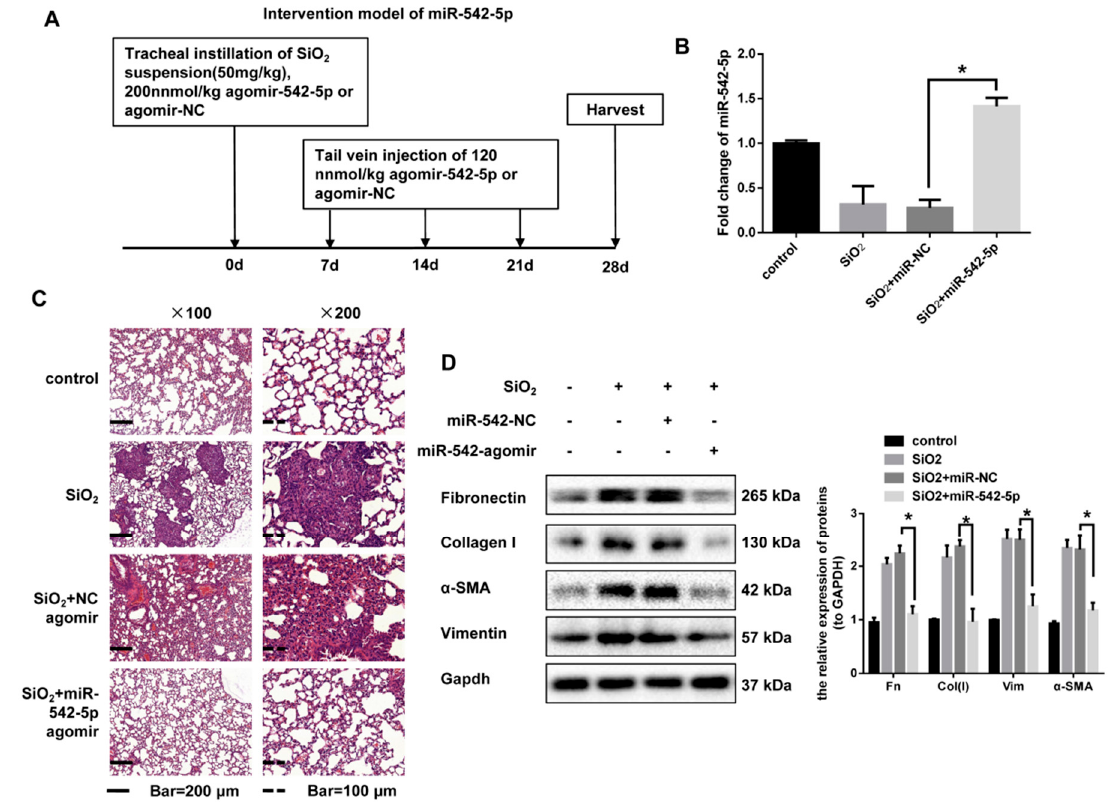
Figure 2. Ectopically expressed miR-542-5p had a therapeutic effect on silica-induced pulmonary fibrosis in mice. ( A ) The mouse model of miR-542-5p overexpression in silica-induced mouse pulmonary fibrosis. The C57BL/6 mice were co-transfected with 200 nmol/kg of either miR-542-5p or miR-NC agomir with 50 mg/kg silica suspension via intratracheal instillation and then injected with 120 nmol/kg miR-542-5p or miR-NC agomir weekly via the tail vein over the next three weeks. Lung tissues were harvested on day 28 ( n = 8 for each group). ( B ) The expression level of miR-542-5p was increased in the lung tissues treated with miR-542-5p agomir, compared with the group treated with the miR-NC agomir. * p < 0.05 versus the SiO 2 + agomir NC group. ( C ) Sections stained with hematoxylin and eosin of the group treated with silica + miR-542-5p agomir showed a lighter degree of fibrosis compared with the group treated with silica or silica + miR-NC agomir; the most representative results were shown here. ( D ) Protein levels of the fibrosis markers (fibronectin, collagen I, α -SMA and vimentin) of the silica + miR-542-5p agomir group were significantly reversed compared with the silica + miR-NC agomir group (randomly n = 3 per group). The gray value of the protein band was quantified by ImageJ and GAPDH was used as an internal reference, * p < 0.05 versus the silica + agomir-NC group. Table 1. Preventive effect of miR-542-5p agomir administration on lung histopathology.